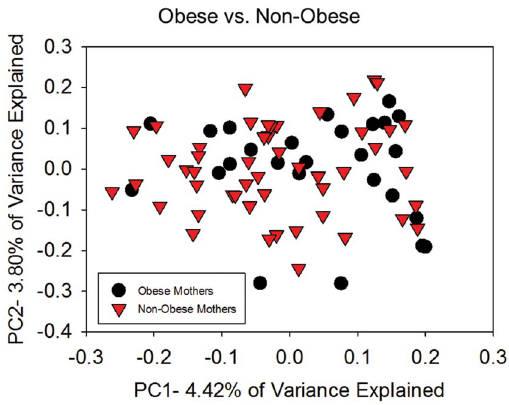
Figure 1. In the overall sample, datapoints did not cluster on a principle coordinate analysis (PCoA) scatter-plot as a function of maternal obesity. The beta-diversity non-parametric statistic adonis showed that children born to obese (n=26) versus non-obese mothers (n=51) had unique microbial profiles ( p =0.044). However, this was due to greater homogeneity among the obese group as measured with permdisp ( p =0.035).